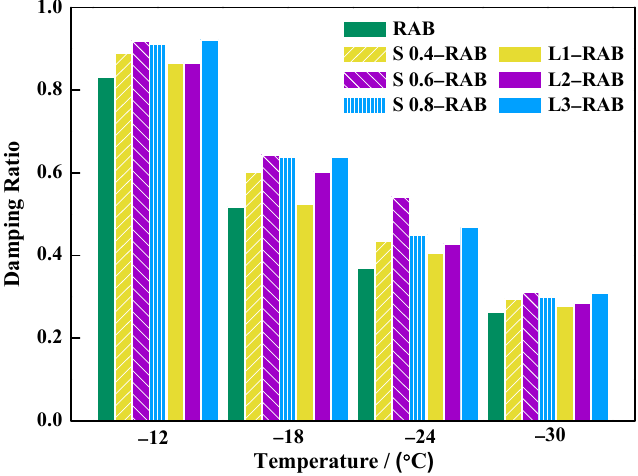
Figure 14. Results of the damping ratio based on the simple fractional model.